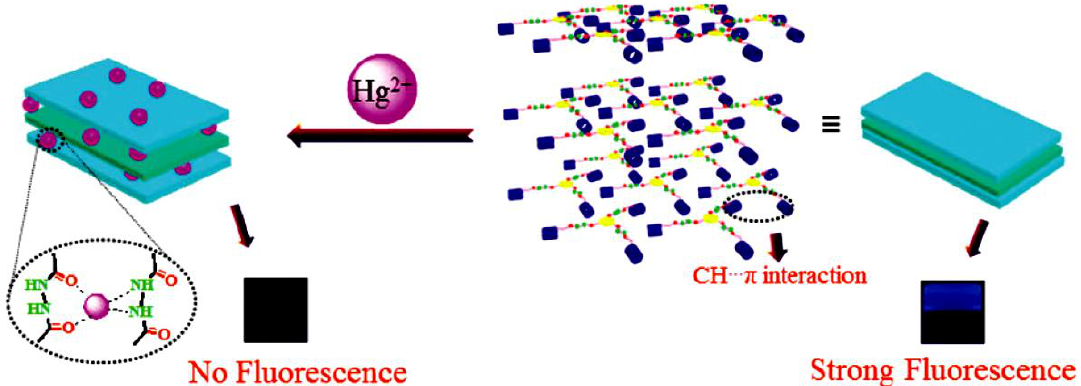
Figure 6. Graphic representation of PT3 -based self-assemblies and their responsiveness towards Hg 2 + . Reproduced with permission from [21]. Copyright Royal Society of Chemistry, 2018.